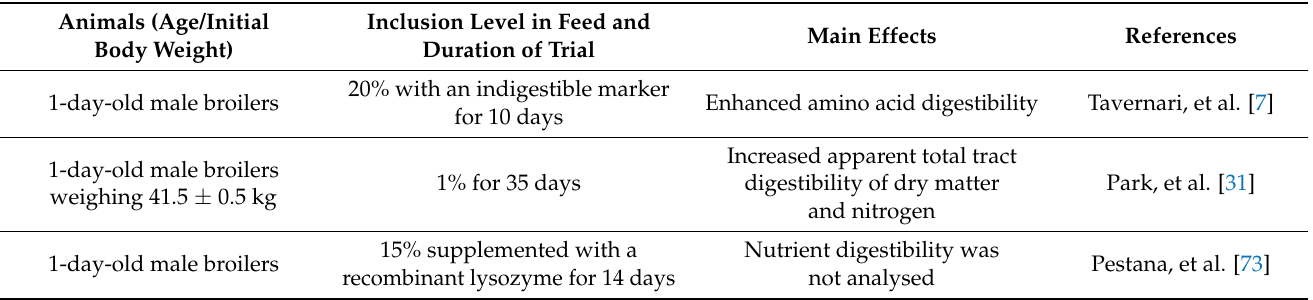
Table 4. Summary of main effects on nutrient digestibility of dietary inclusion of A. platensis in in vivo trials on